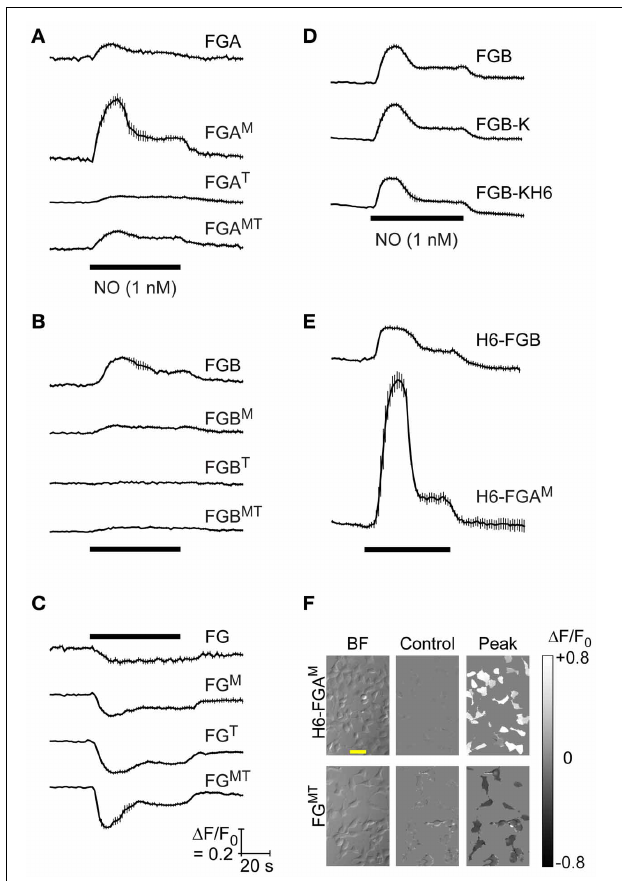
FIGURE 2 | Responsiveness to NO of HEK GC / PDE5 cells transfected with FlincG variants. (A–E) Representative recordings (from 3 to 4 experiments) of HEK GC / PDE5 cells transfected with the indicated FlincG variants (grouped as in Figure 1 ) and exposed to 1nM NO for 1min (horizontal bars). Traces are averages of 5–20 cells; vertical bars are ± SEM. Calibrations ( C , bottom) apply to all panels. (F) Sample brightfield images (“BF”, left), together with the baseline fluorescence (“Control”, center) and maximal NO-induced change in fluorescence (“Peak”, right), coded into the grayscale shown on the extreme right, of cells transfected with H6-FGA M (top) and FG MT (bottom); scale bar (in the top left image) = 50 μ m.